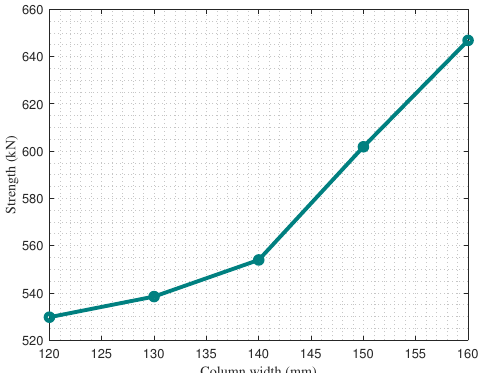
Figure 11. Shear wall strength S for different CFST column widths, a